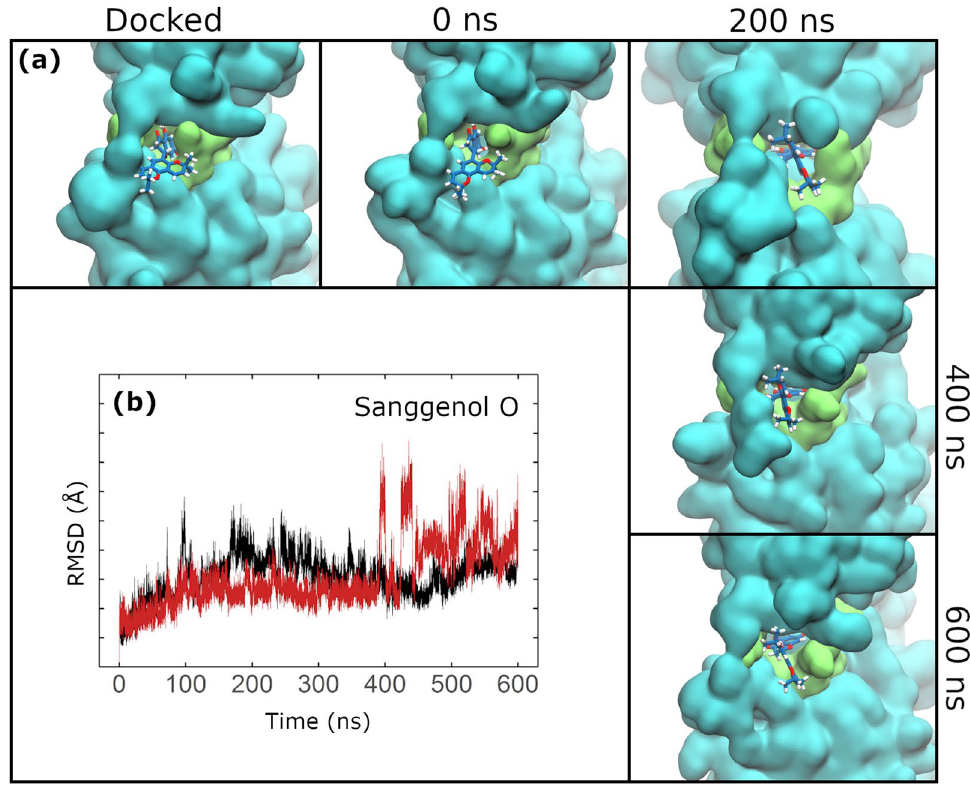
Figure 4. Sanggenol O-induced conformational changes in region A. ( a ) Snapshots of sanggenol O throughout the MD are shown each 200 ns. Residues from region A are shown in green surface while the rest of the protein is shown in cyan. Ligand backbone is coloured blue and other atoms follow the CPK colouring convention. ( b ) Ligand-induced RMSD variations in SBS residues are shown in red. RMSD of the apo- monomer structure is provided for comparison